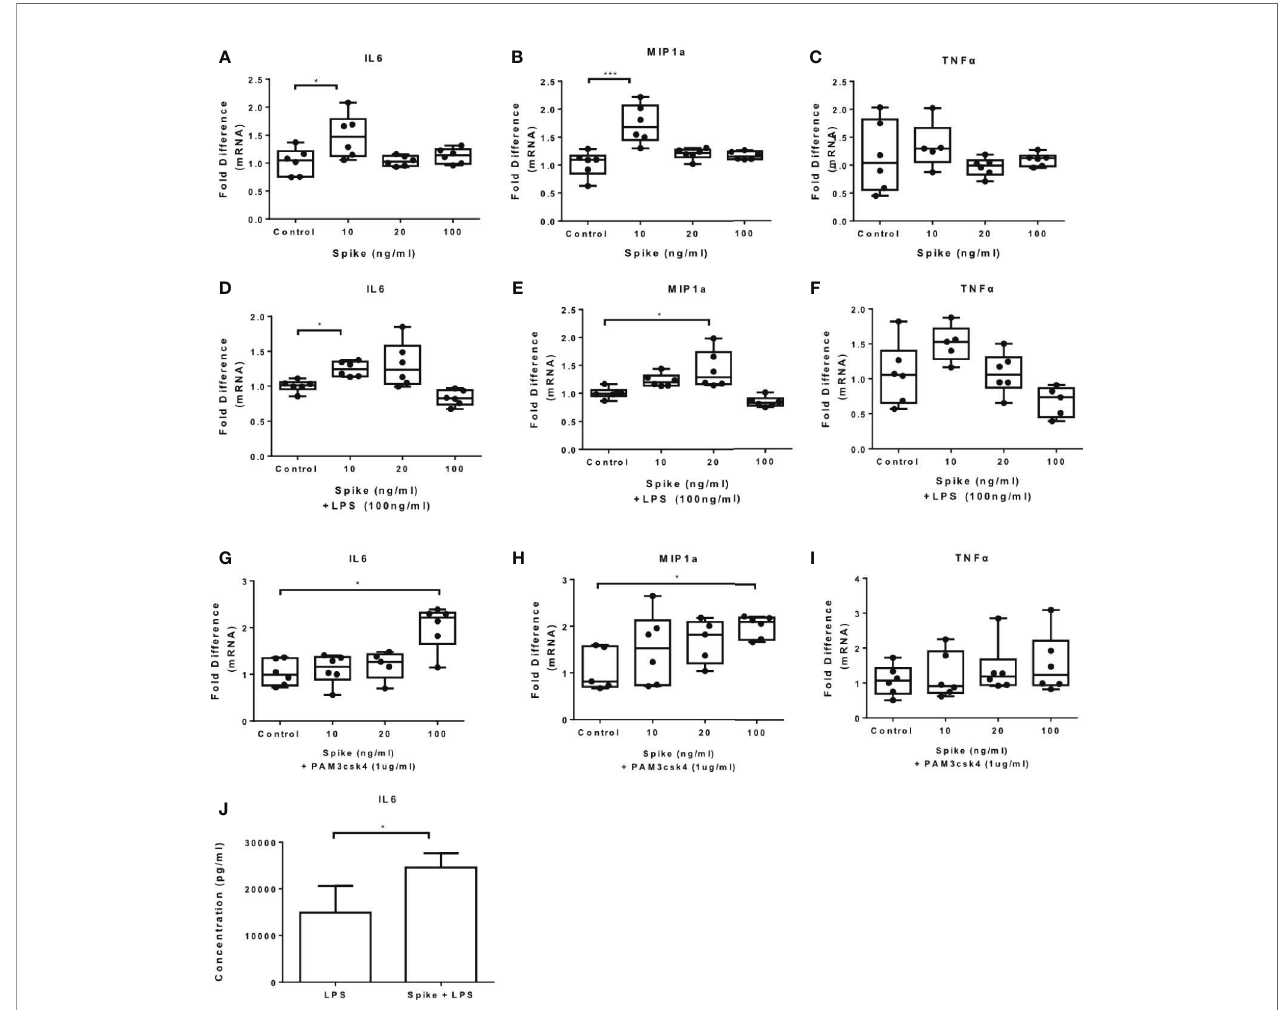
FIGURE 5 | SARS-CoV-2 S protein increased cytokine expression in PBMCs. PBMCs were treated with various concentrations of SARS-CoV-2 S protein and stimulated with TLR ligands. (A, B) IL6 and MIP1a expression was increased in the presence of SARS-CoV-2 S protein. (C) No effect observed for TNFa expression, (D, E) LPS-induced IL6 and MIP1a expression was increased, (F) No effect observed for LPS-induced TNF a expression. (G, H) PAM3csk4-induced IL6 and MIP1a expression was increased, (I) No effect was observed for PAM3csk4-induced TNF a expression, (J) Increased IL6 secretion for LPS stimulated PBMCs. Data are illustrated in box-and-whiskers, plotted as median (± min, max) and statistical analysis was performed with Kruskal - Wallis test, regarding qPCR results. For Elisa, data are illustrated in bars, plotted as median with range and statistical analysis was performed with Mann – Whitney U test. *p < 0.05, ***p